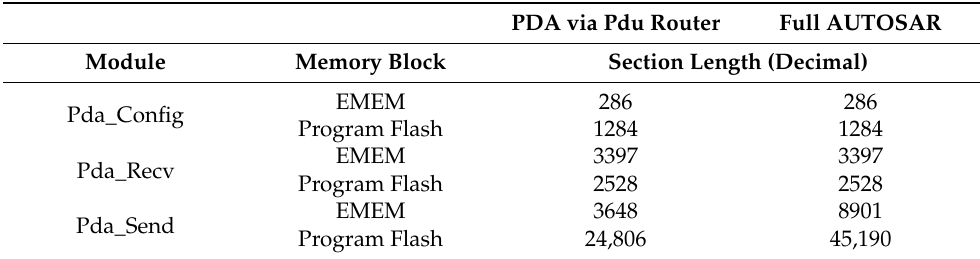
Table 1. PDA via Pdu Router vs. Full AUTOSAR Module